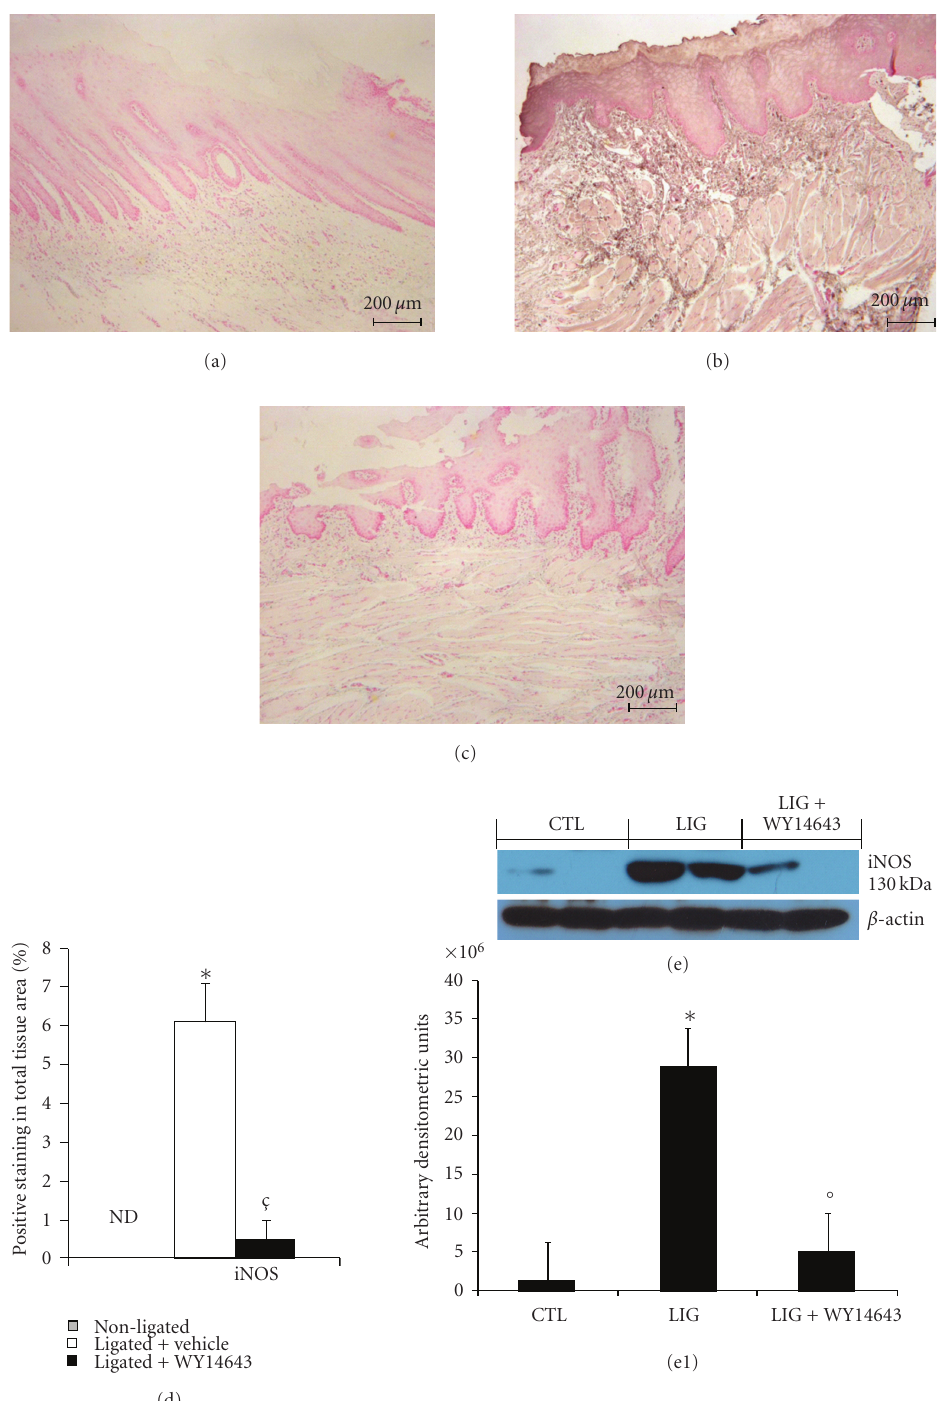
Figure 5: E ff ect of WY14643 on iNOS expression. Sections of gingivomucosal tissues from the contra lateral side obtained from vehicle- treated rats did not reveal any immunoreactivity for iNOS. (a) Positive staining for iNOS (b) was observed in gingivomucosal tissue after ligature. In gingivomucosal tissue of WY14643 treated rats no positive staining was observed for iNOS. (c) Densitometry analysis of immunocytochemistry photographs; ((d) n = 5 photos from each samples collected from all rats in each experimental group) for iNOS from gingivomucosal tissue was assessed. The assay was carried out by using Optilab Graftek software on a Macintosh personal computer (CPU G3-266). Densitometry data are expressed as % of total tissue area. Moreover, a significant increase in iNOS expression (e, e1), assayed by Western blot analysis, was detected in in gingivomucosal tissue after ligature. Treatment with WY14643 significantly attenuated iNOS (e, e1) expression in gingivomucosal tissue after ligature. A representative blot of lysates (e, e1) obtained from 5 animals per group is shown and densitometry analysis of all animals is reported. Figure is representative of at least 3 experiments performed on di ff erent experimental days. ∗ P < . 01 versus nonligated. ◦ P < . 01 versus